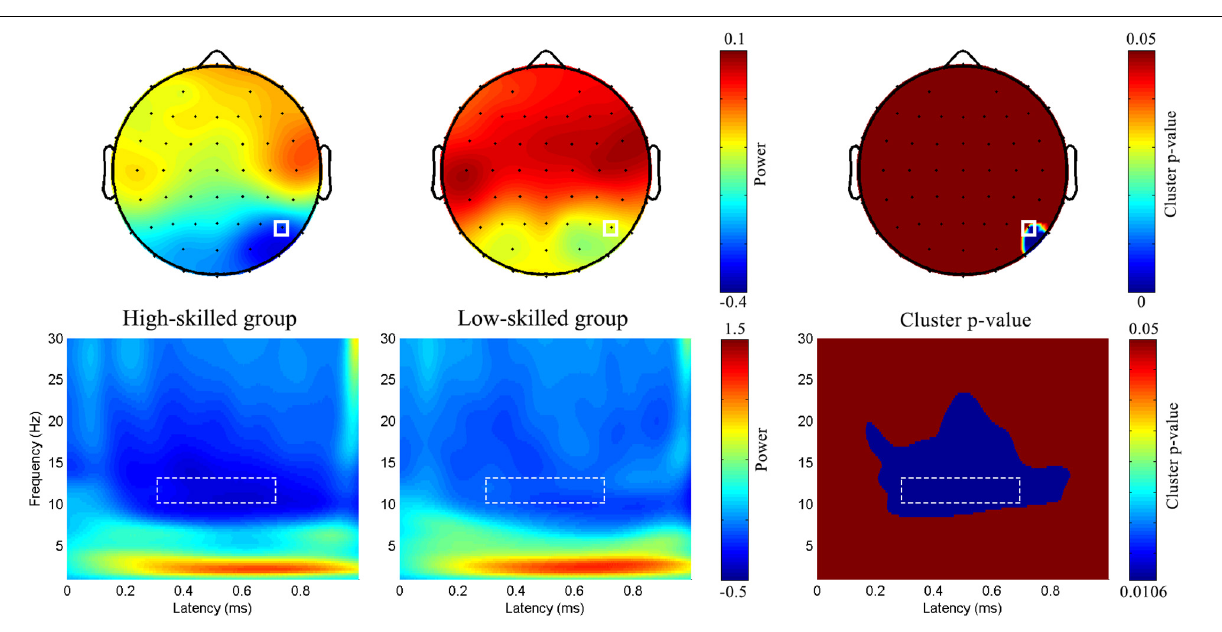
FIGURE 6 | Group-level topographic map and time-frequency features in the relative discount. Full rectangle represented P6